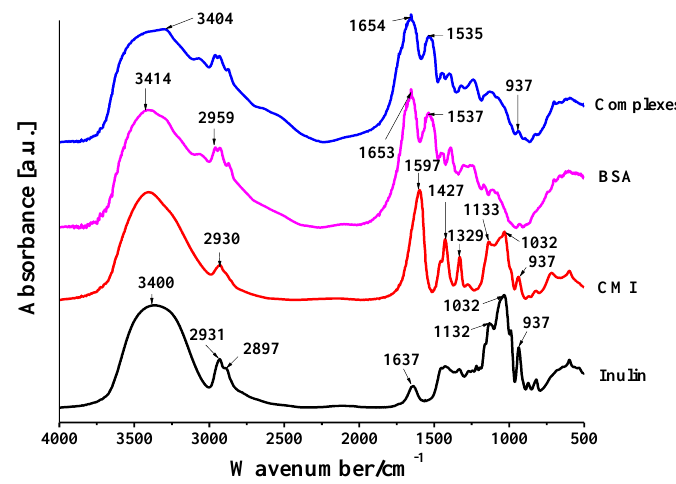
Figure 2. Infrared spectra of inulin, carboxyl methyl inulin (CMI), bovine serum albumin (BSA), and CMI/BSA complexes.